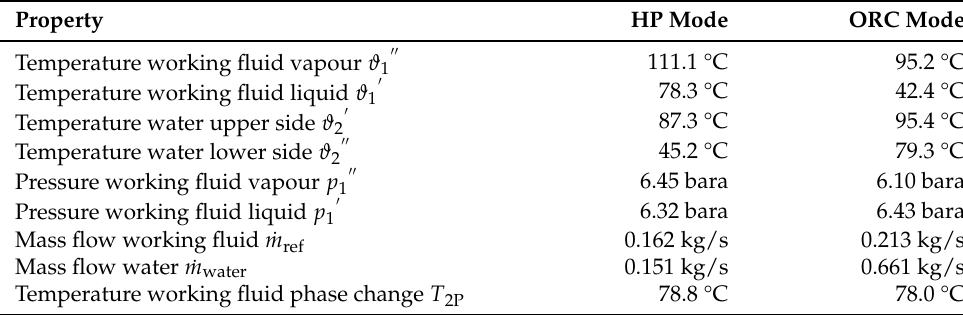
Table 1. Properties of the upper heat exchanger in HP and ORC mode.